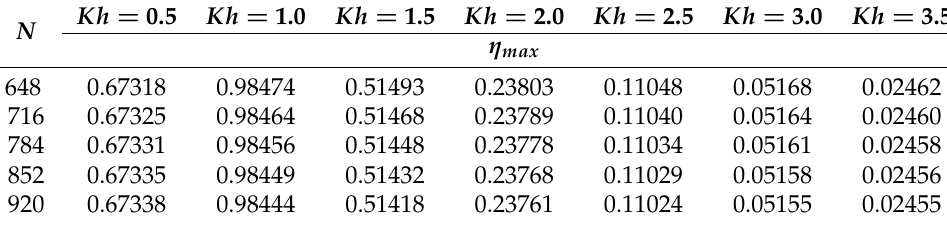
Table 3. Convergence of the maximum hydrodynamic efficiency η max computed for different numbers of nodes N bem with a 1 / h = a 2 / h = 0.5, w 1 / h = w 2 / h = 0.125 b / h = 1.0 and h e / h = 1 without the reflecting vertical